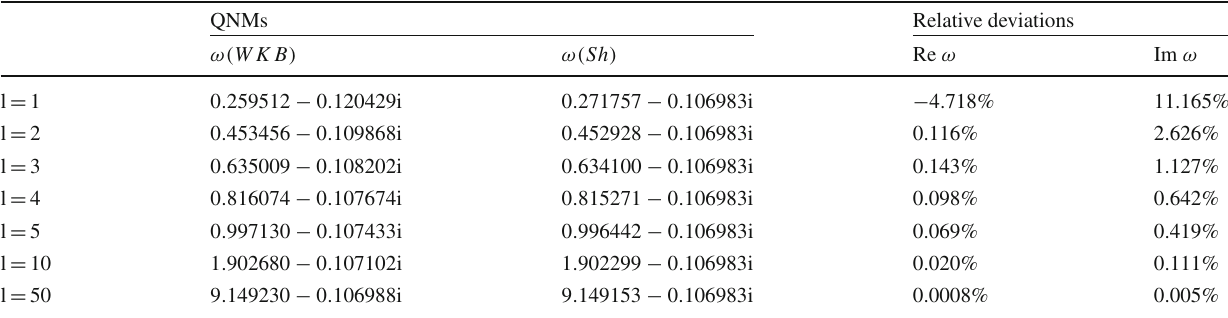
Table 3 The QNMs derived by the WKB approximation approach and shadow radius and the relative deviations. In the calculation, we let Q = 0 . 1 and α = − 1